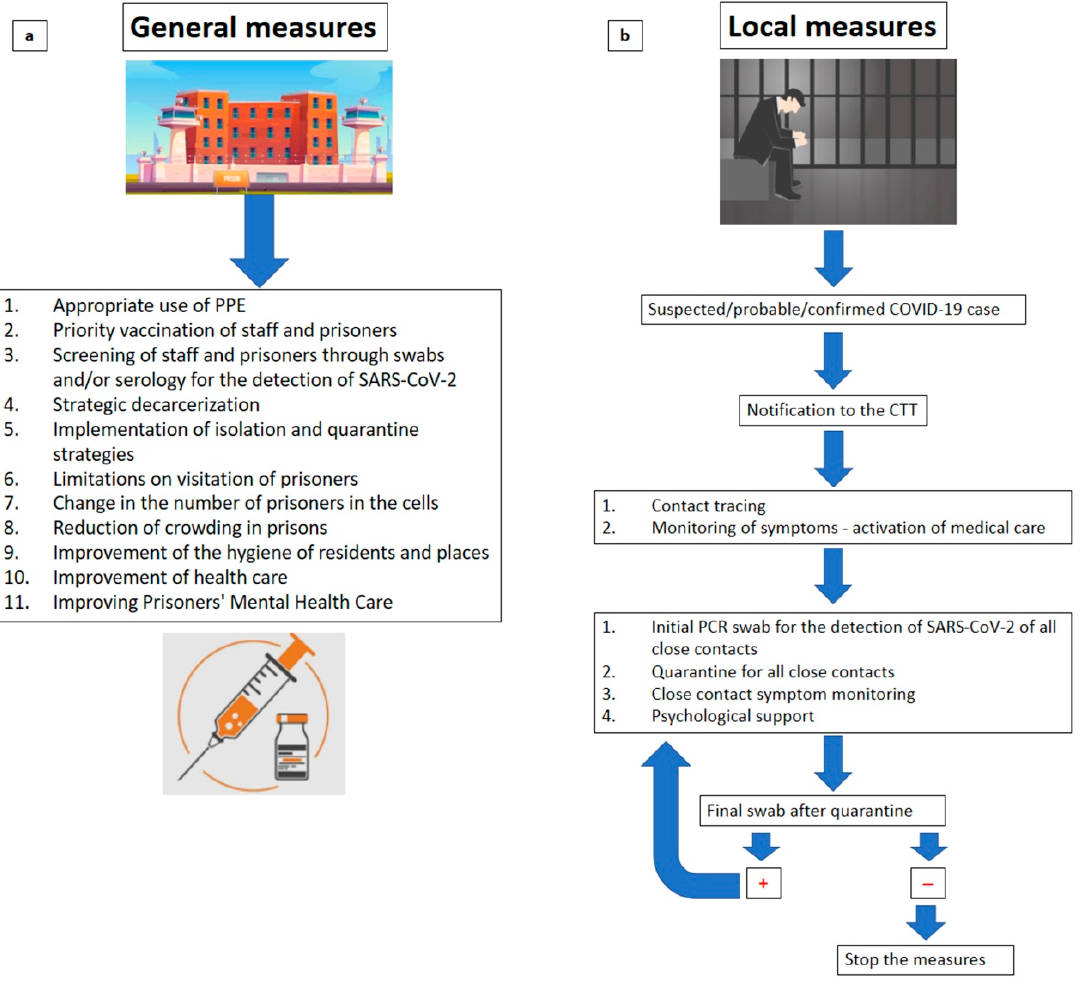
Figure 2. COVID-19 prevention measures in prisons in general ( a ) and within the single prison ( b ).